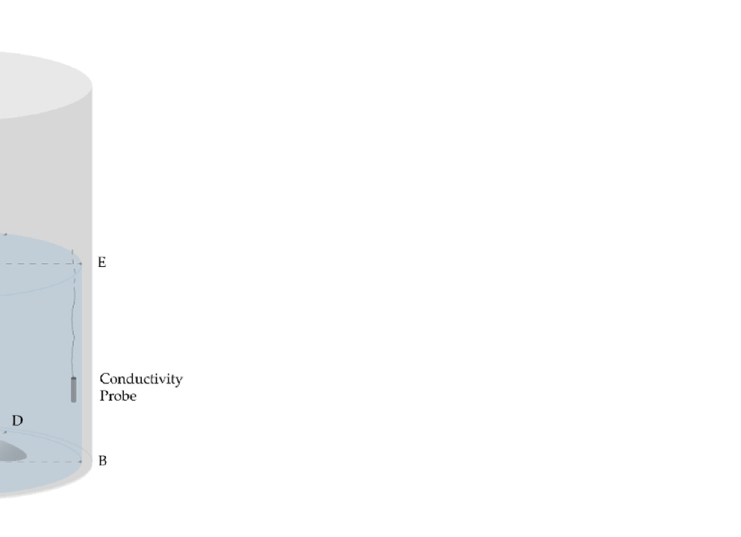
Figure 2. Schematic representing the mixing time trial setup. The probe positions are classified by the letters A, B, C, D and E. Table 1. Summary of the mixing time trials classified by the rotational speed, volume of water and probe